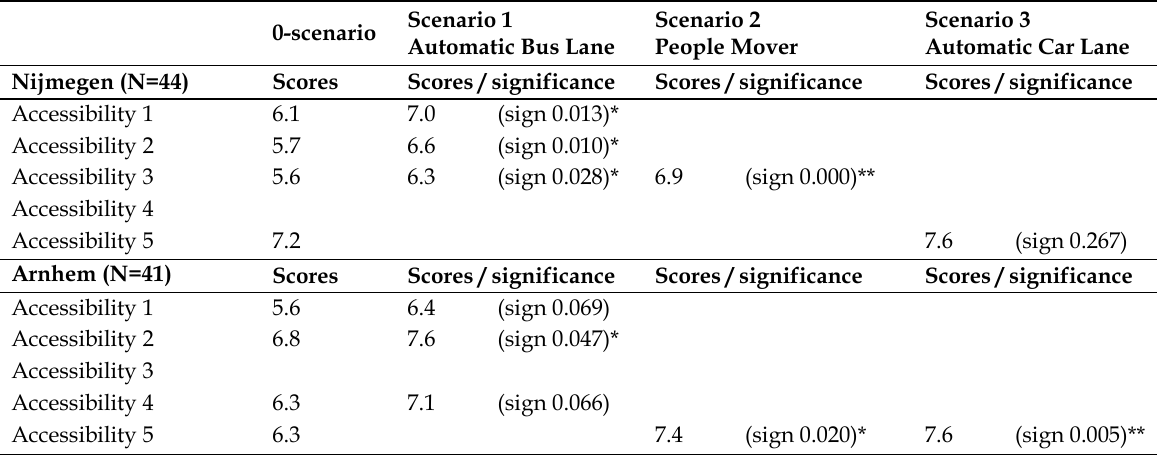
Table 5. Observed accessibility scores for the ITS scenarios compared to the